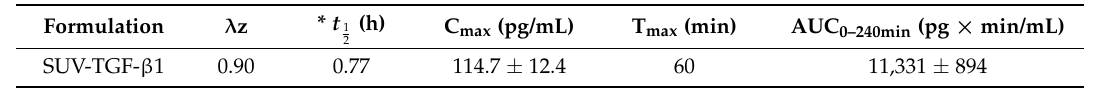
Figure 4. Bioavailability of the novel TGF- β 1 formulation in rabbit vitreous. * p < 0.01 vs. basal level (control animals) (35.60 ± 10 pg/mL). The curve was normalized to TGF- β 1 basal levels. Table 1. Pharmacokinetics (PK )parameters.